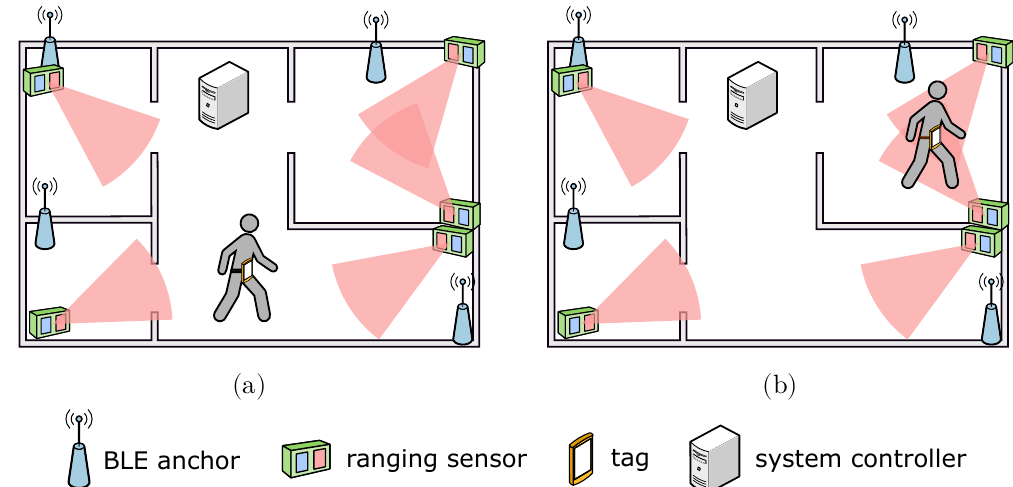
Figure 1. Hybrid localization use scenario. ( a ) User is localized using BLE only. ( b ) User is localized using BLE and proximity